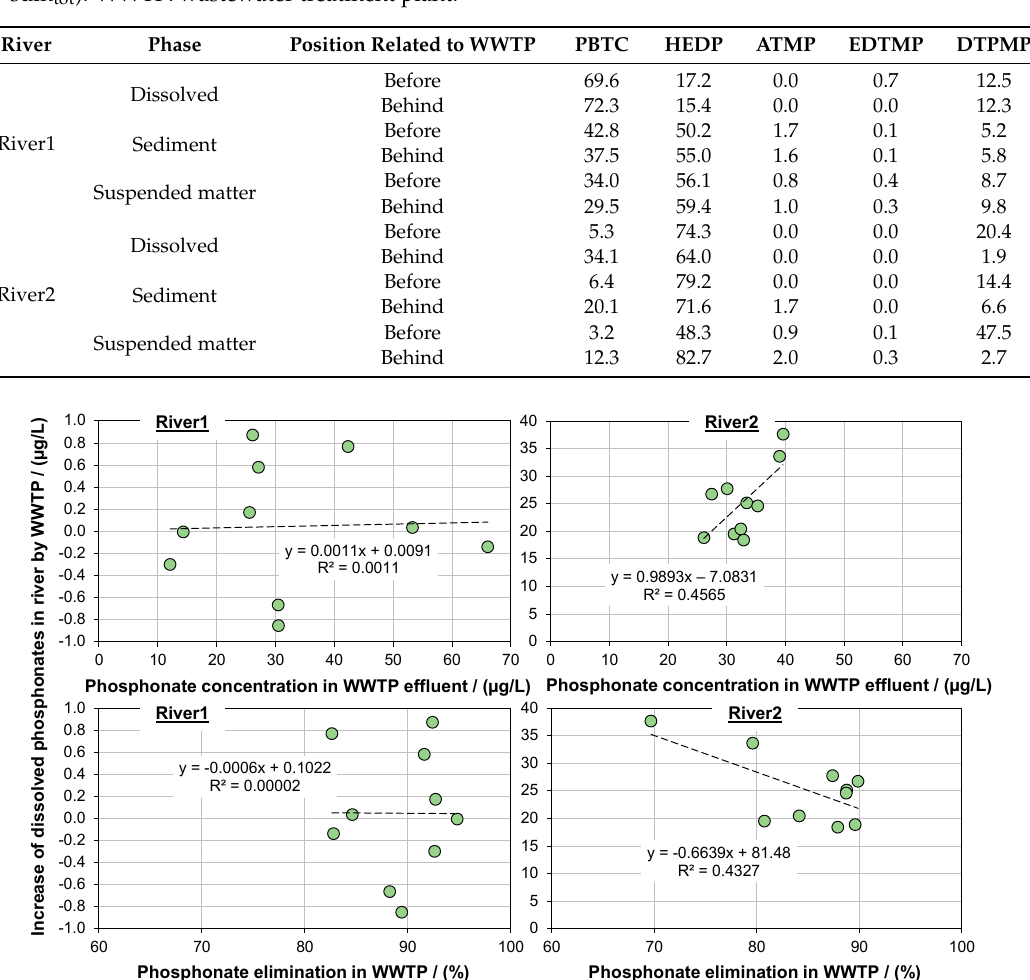
Table 1. Contribution of single phosphonates to the total phosphonate content of the three di ff erent river phases (in % by mass) (determination: summation of the concentrations and loads of each individual phosphonate (sum ind ) and of total phosphonates (sum tot ) over all samples; quotient of sum ind and sum tot ). WWTP: wastewater treatment plant.